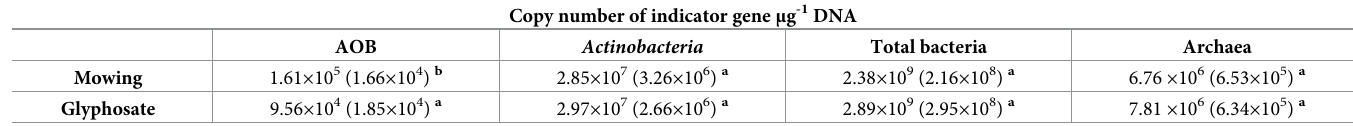
Table 5. Copy number of indicator genes from different microbial groups in the rhizosphere of glyphosate-treated or cut plants. Mean values were calculated through all sampling times (no interaction detected, n = 16). Values between brackets indicate the standard error of the mean. Only those microbial groups in which no interaction was observed are shown. Different letters indicate statistically significant differences ( P < 0.05). Copy number of indicator gene μ g -1 DNA AOB Actinobacteria Total bacteria Archaea